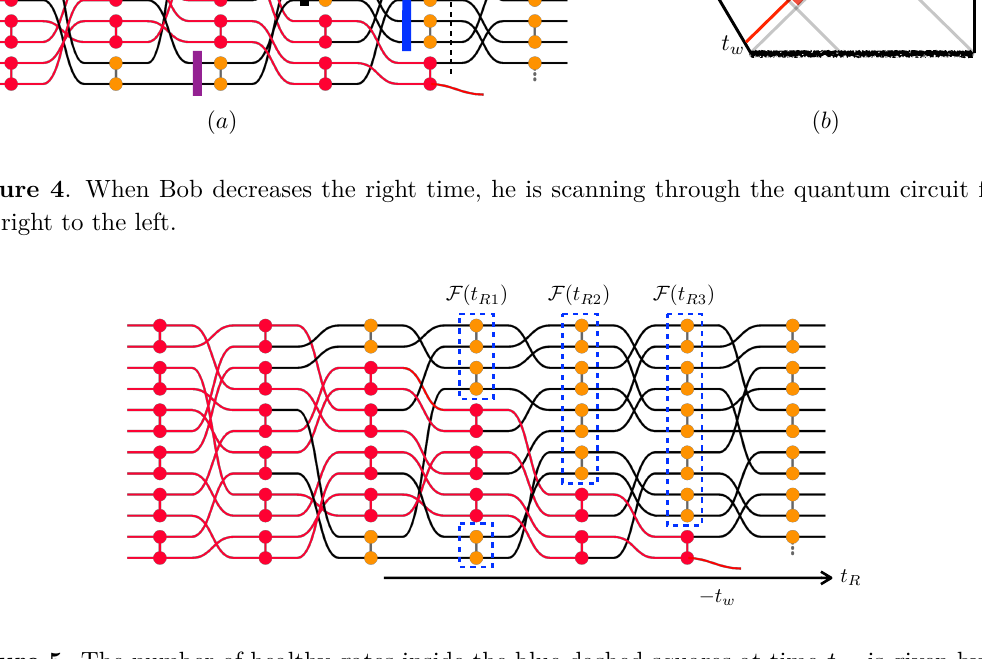
Figure 5 . The number of healthy gates inside the blue dashed squares at time t Ri is given by F